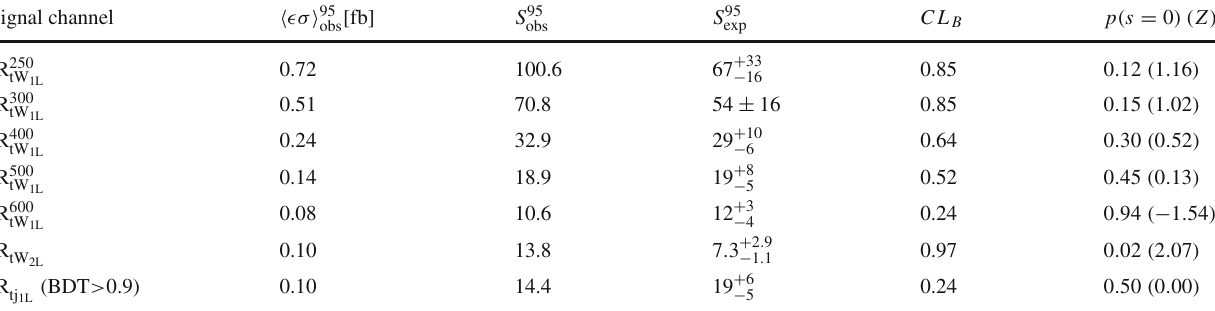
Table 9 The 95% CL upper limits on the visible cross section ( (cid:5) (cid:15)σ (cid:6) 95 number (and ± 1 σ exclusions of the expectation) of background events. ) obs The last two columns indicate the CL B value, i.e. the confidence level and on the number of signal events ( S 95 ) for all SRs and analysis chan- obs observedforthebackground-onlyhypothesis,andthediscovery p -value nels as detailed in the text. The fourth column ( S 95 exp ) shows the 95% ( p ( s = 0 ) ). The associated significance is provided in CL upper limit on the number of signal events, given the expected